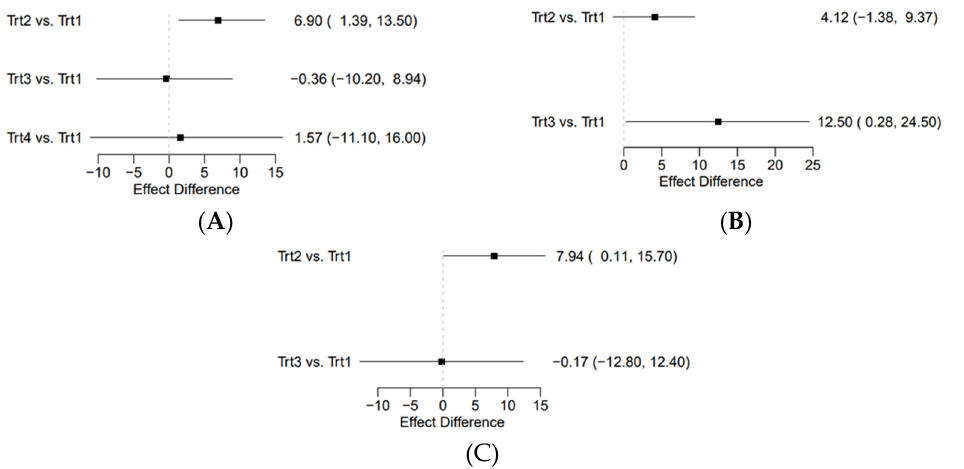
Figure 3. Contrast plot for object control outcome ( A ), locomotor outcome ( B ), and gross motor outcome ( C ). Abbreviations: Trt1, reference intervention arm (control); Trt2, aerobic (traditional intervention); Trt3, exergaming intervention; Trt4, parent/teacher education intervention. Squares represent comparative standardized mean differences, and their associated lines are 95% credible intervals with 2.5% and 97.5% quantiles as the lower and upper bounds.